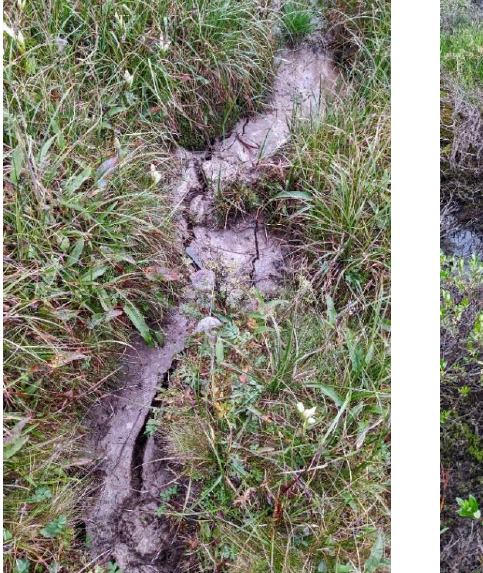
plot presented in Figure 5.